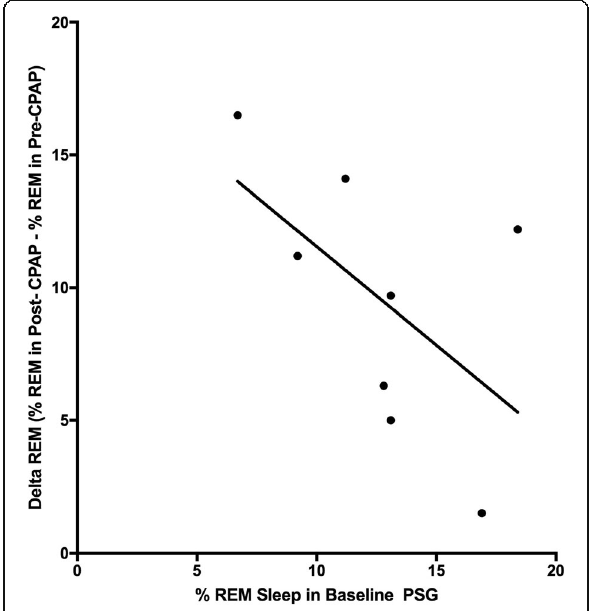
Fig. 5 Correlation between percentage of REM sleep on baseline PSG and amount of REM rebound (Delta REM) on CPAP titration